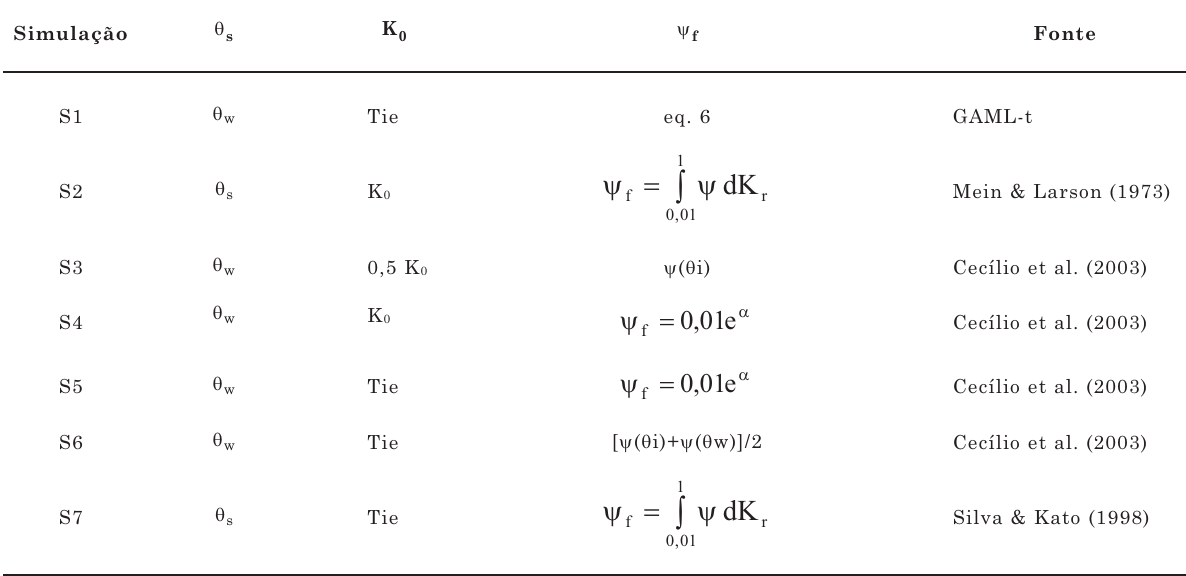
: potencial matricial de entrada de ar; λ : índice de distribuição de tamanho de poros. b